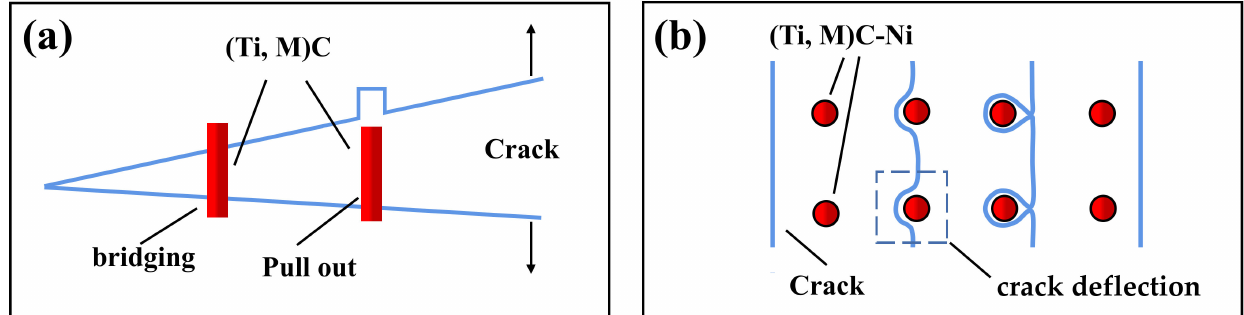
Figure 11. ( a ) Crack bridging mechanism of (Ti, M) C, ( b ) Crack bridging mechanism of (Ti, M)